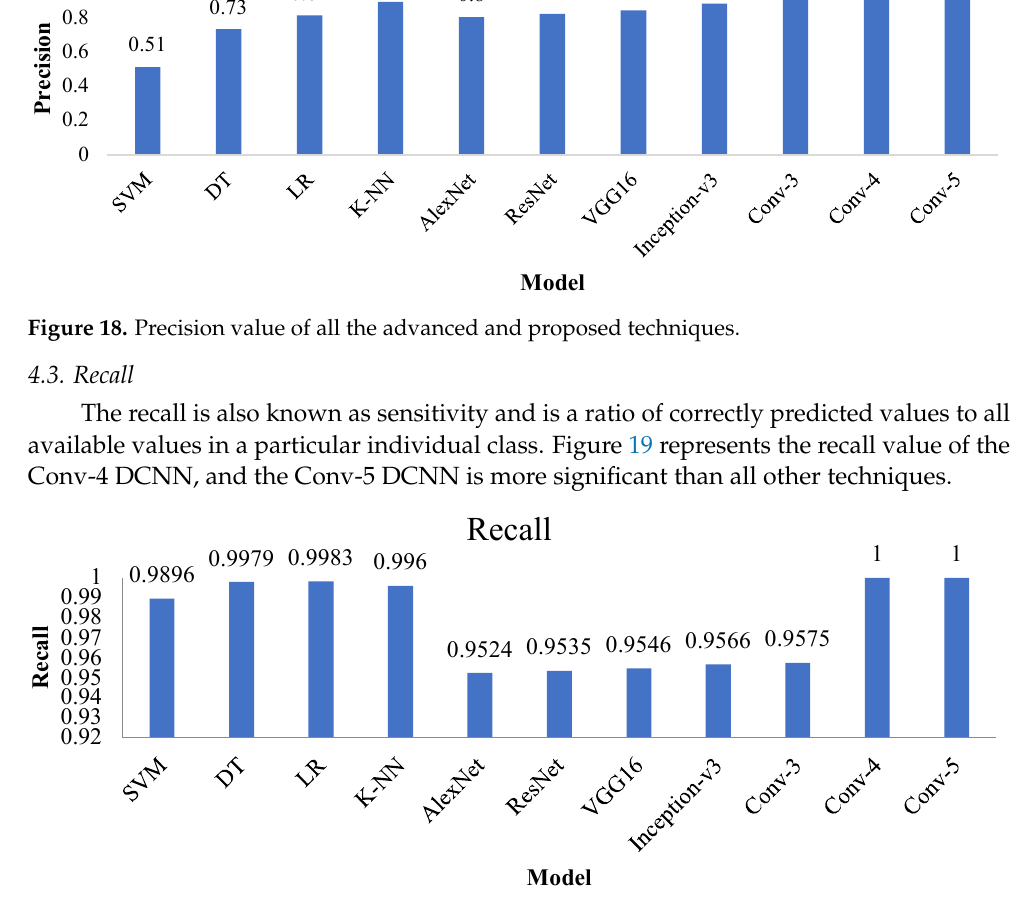
Figure 19. Recall value of all the advanced and proposed techniques.